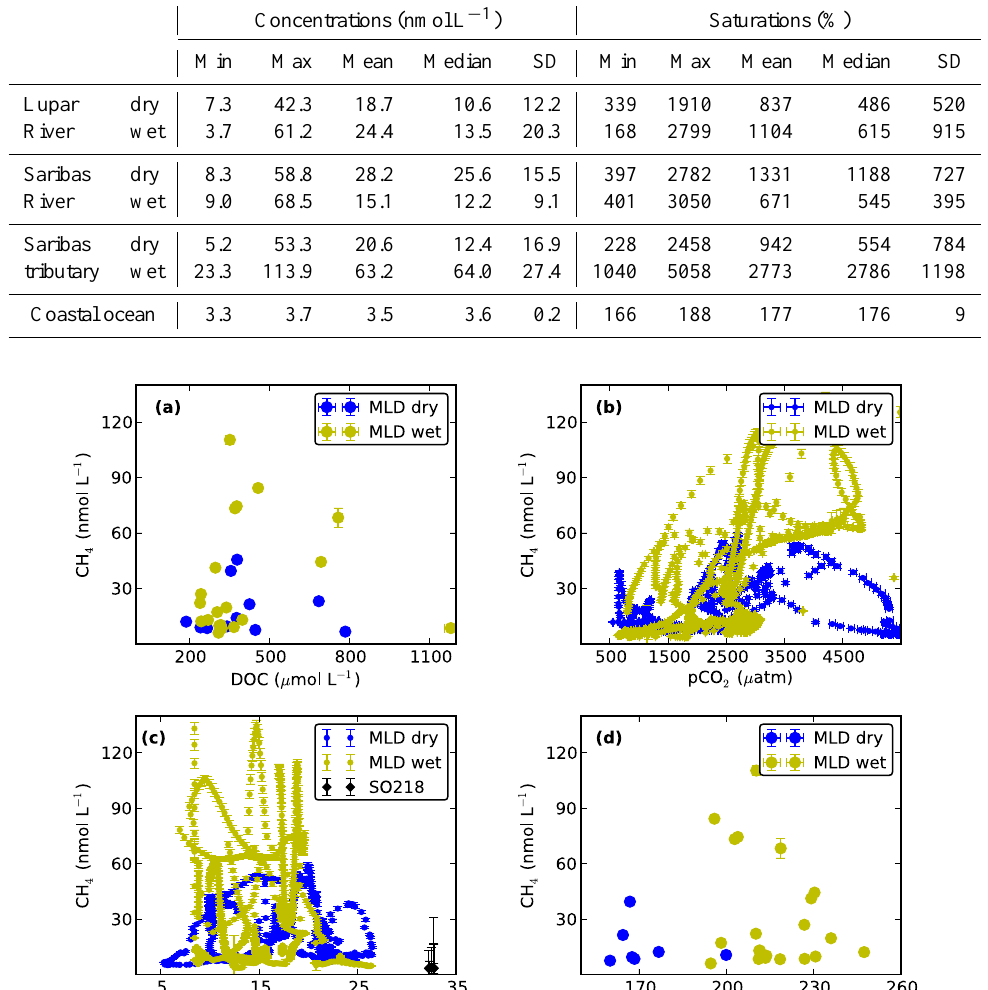
Table 3. CH 4 concentrations and saturations in the Lupar River, Saribas River, Saribas tributary, and coastal ocean. Values for the estuaries are given for the spatial extent of the rivers that was covered in 2013.